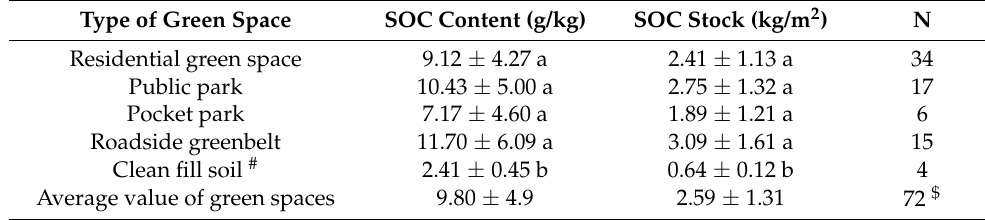
Table 1. SOC content and stock in different green space types (mean ± SE).